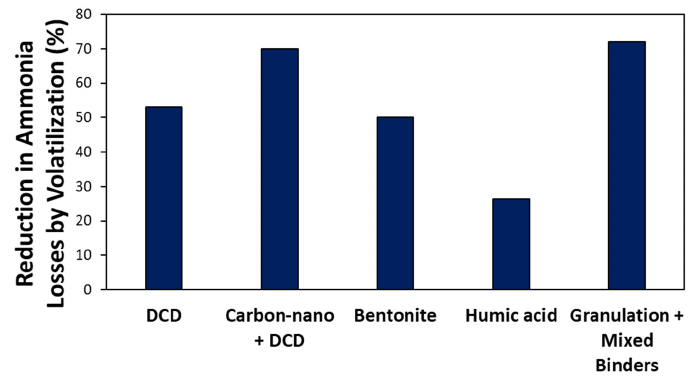
Figure 8. E ff ect of some methods on ammonia loss reduction from granulated ammonium Figure 8. Effect of some methods on ammonia loss reduction from granulated ammonium bicarbonate bicarbonate fertilizer materials. Compiled from [45,46,48,53,59]. fertilizer materials. Compiled from Table 2. Summarized studies to increase ammonium bicarbonate stability.